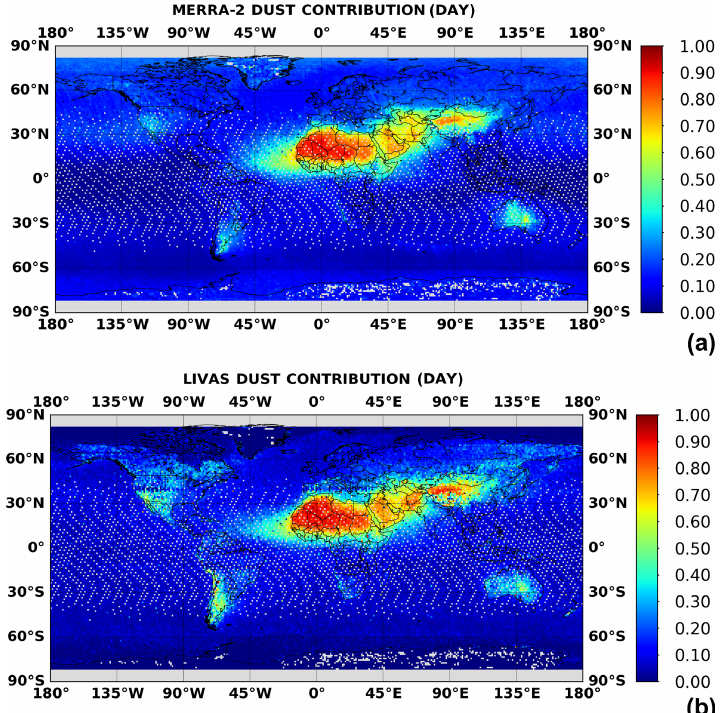
Figure 1. Annual geographical distributions of dust contribution to total aerosol optical depth at 1 ◦ × 1 ◦ spatial resolution based on